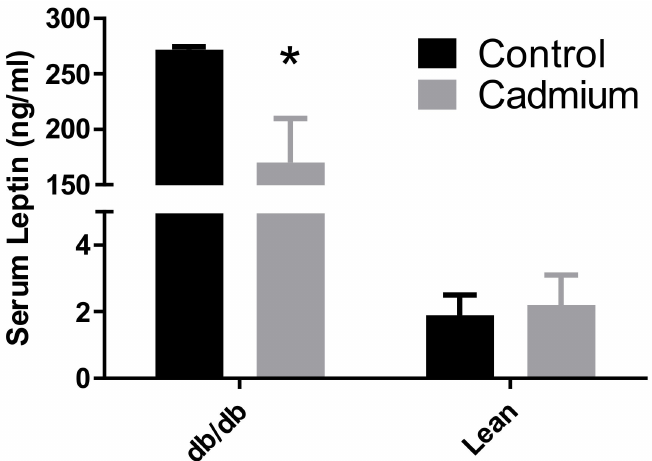
Figure 2. Serum leptin levels following two weeks of 0.6 mg/kg/b.w./day of Cd dosing and two subsequent weeks of no Cd dosing. Asterisk (*) indicates significant differences between saline control and Cd-treated db/db mice. Two-way ANOVA with Tukey’s multiple comparison post-tests test; p ≤ 0.05 was considered significant; N = 4 per group for mice and N = 6 for rats per group; data are mean ±